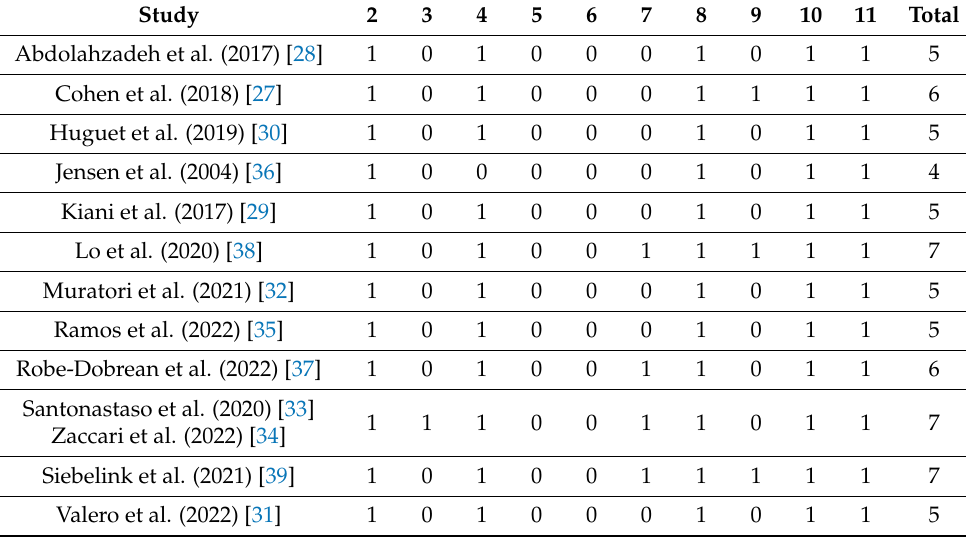
Table 2. Methodological quality assessment of included studies on the PEDro Scale.